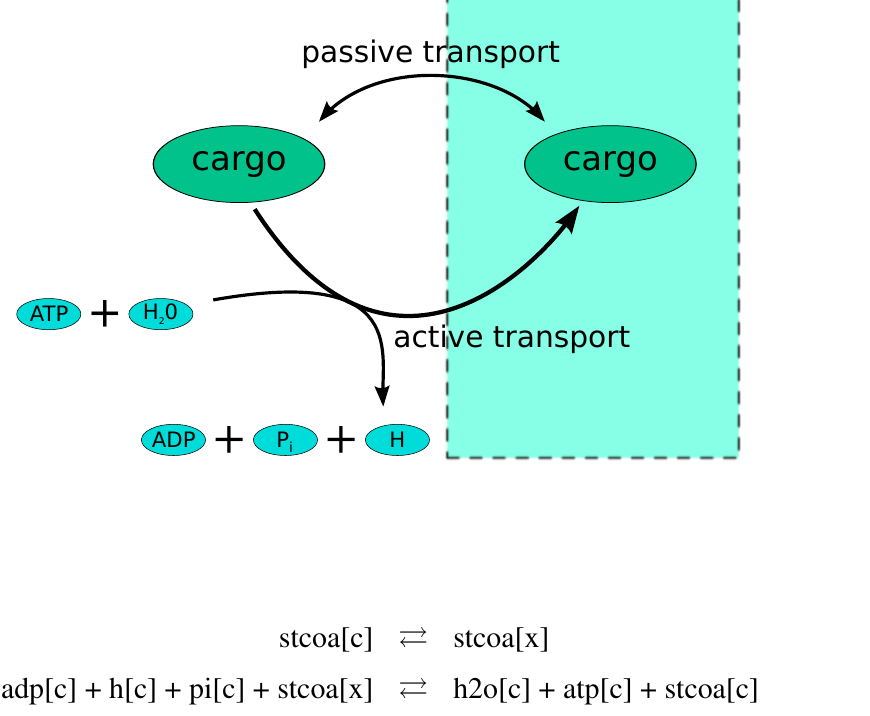
membrane-enclosed compartment: a passive one (by diffusion) and an active one (requiring the expenditure of energy). If the active process is allowed to reverse and the cargo re-enters the cell or compartment via diffusion, an infeasible loop is generated that builds ATP from ADP without energetic